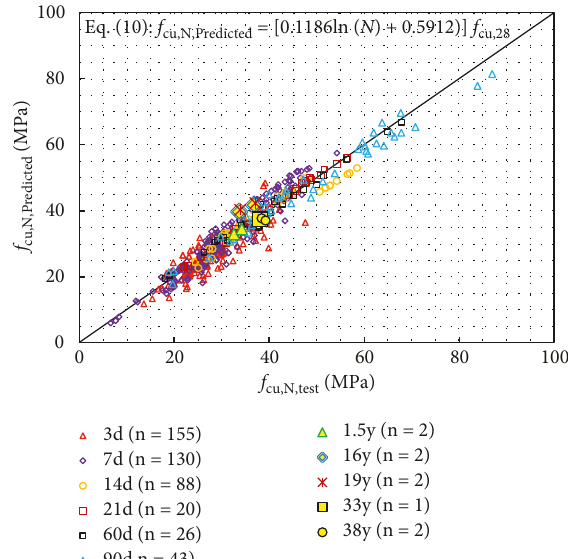
Figure 17: Comparison between predicted results and measured results of coral concrete